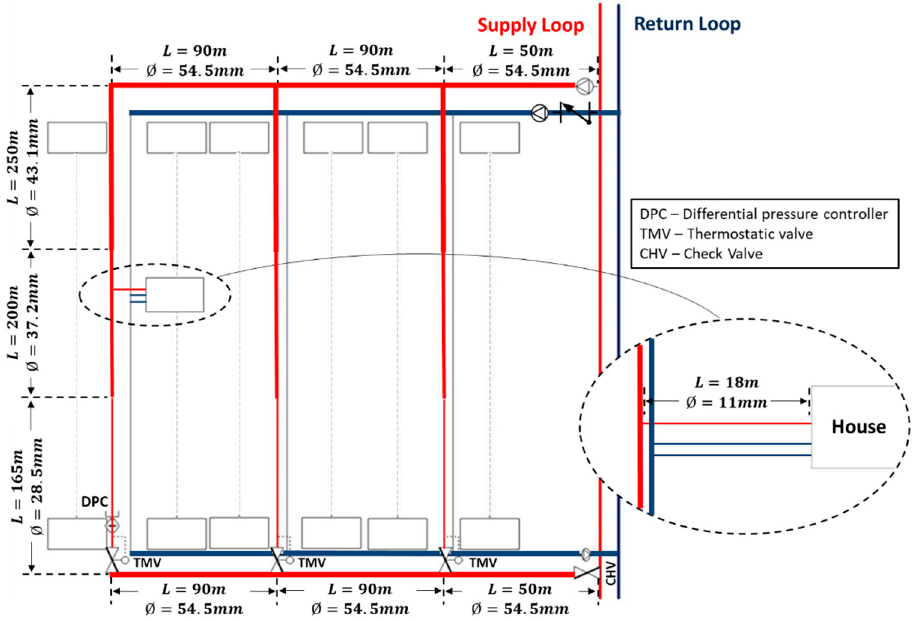
Figure 2. Connection of cluster of 150 houses to the main loops.